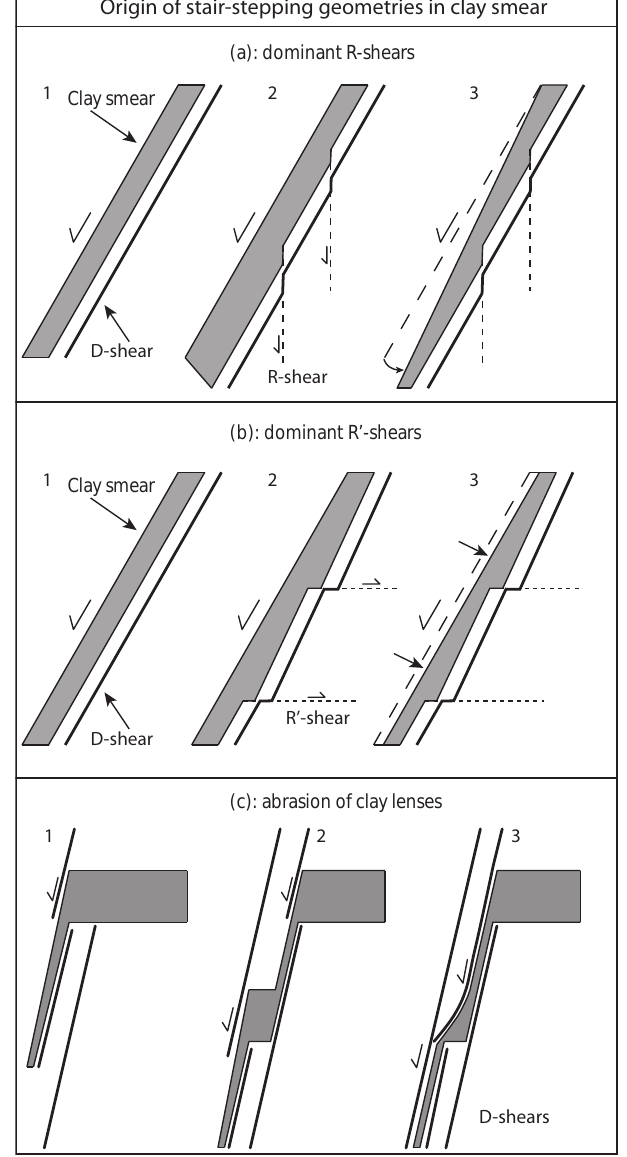
Figure 15. Possible origin of stair-stepping geometries in clay smear: (a) dominant R shears offset the sand–clay interface and D and R’ shears (cf. Fig. 13), and plastic deformation of the clay smear is required to preserve the clay volume; (b) dominant R’ shears off- set the clay-sand interface and D and R shears (cf. Fig. 14), and plastic deformation of the clay is required to preserve the clay vol- ume; (c) clay lenses with an abraded hanging-wall side can form stair-steps in the footwall in the absence of R or R’ shears. Clay is not required to behave like plastic.